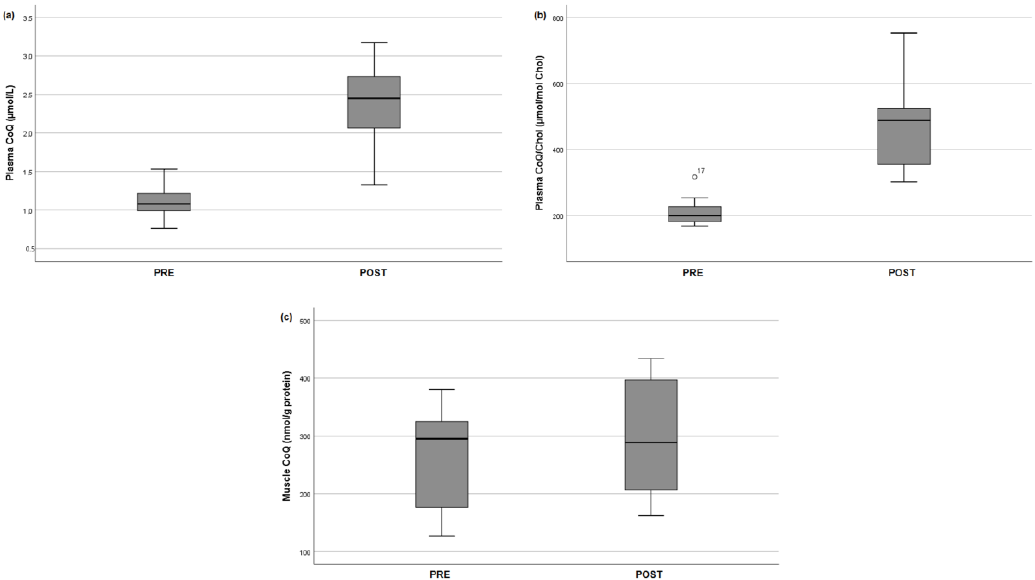
Figure 3. Box-plot representation of plasma CoQ values expressed as absolute values ( a ) and values relative to total cholesterol ( b ), and of muscle CoQ concentrations ( c ) before (PRE) and after (POST) CoQ supplementation. The length of the boxes indicates the interquartile space (p25–p75), the horizontal line into the box represents the median (p50), and the circle indicates an outlier value.